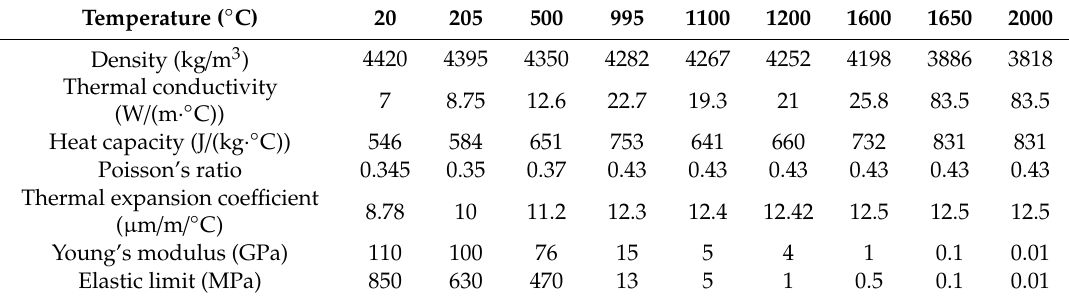
Table 2. Temperature-dependent material properties of Ti-6Al-4V alloy, data from